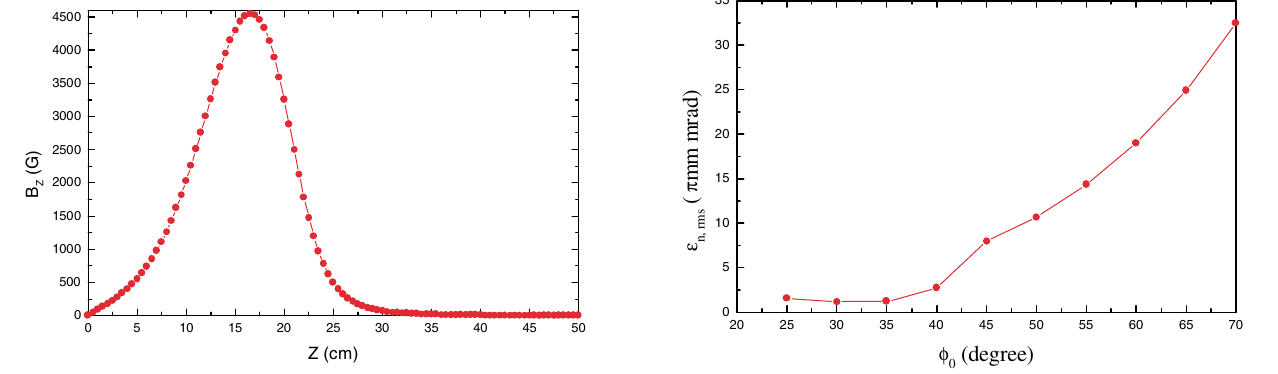
FIG. 3. (Color) Magnetic field distribution of the solenoid